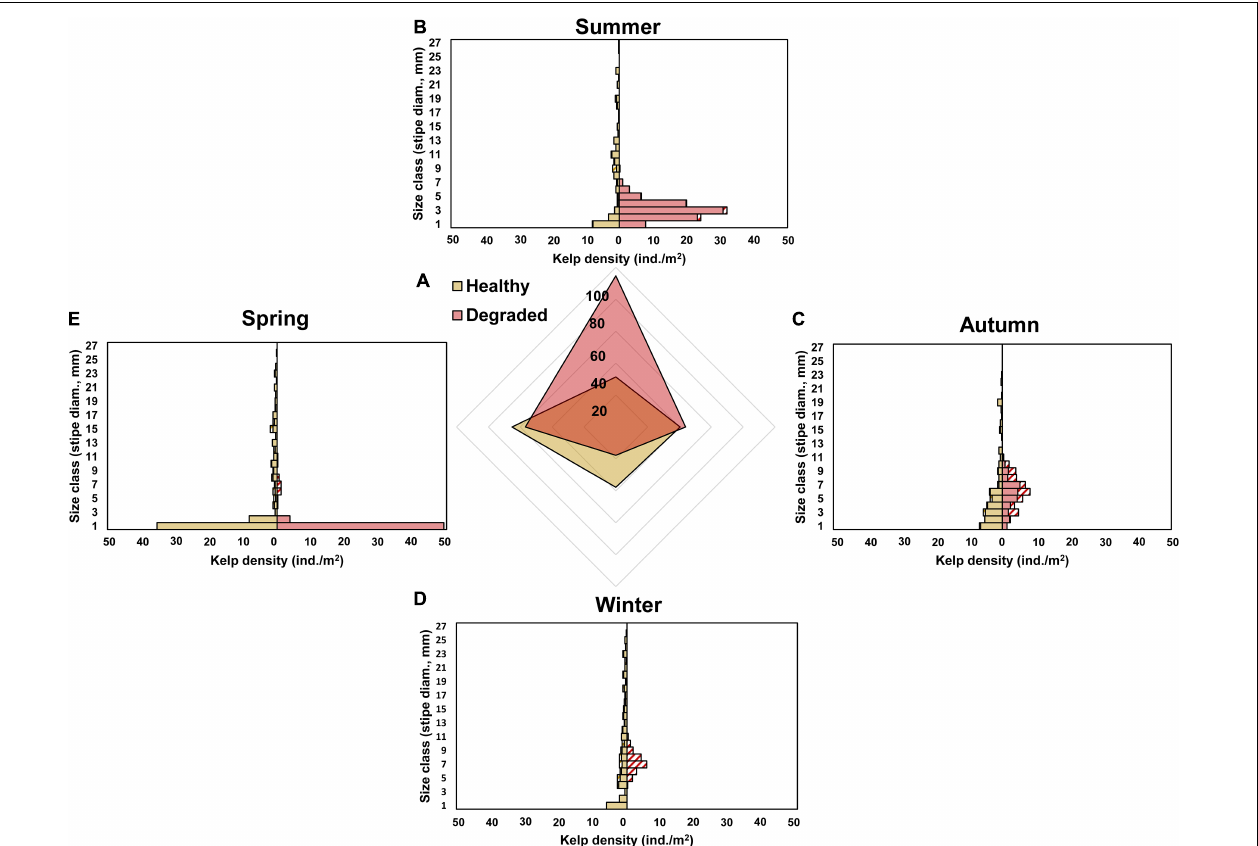
FIGURE 3 | Laminaria ochroleuca. Seasonal changes in the density (as number of individuals per m 2 ) recorded on healthy and degraded golden kelp reefs. Abundance estimates shown for (A) the whole population and (B–E) for kelps separated into size classes according to stipe diameter (stipe diameter recorded just above the holdfast). The radar plot (A) shows seasonal averages for healthy (light shading) and degraded (dark shading) reefs (four sampling sites for each reef type, five sampling quadrats per site); plot axes point to the corresponding season of the year. Striped bars in panels (B–E) are ecologically dead plants that lost their growth meristem due to